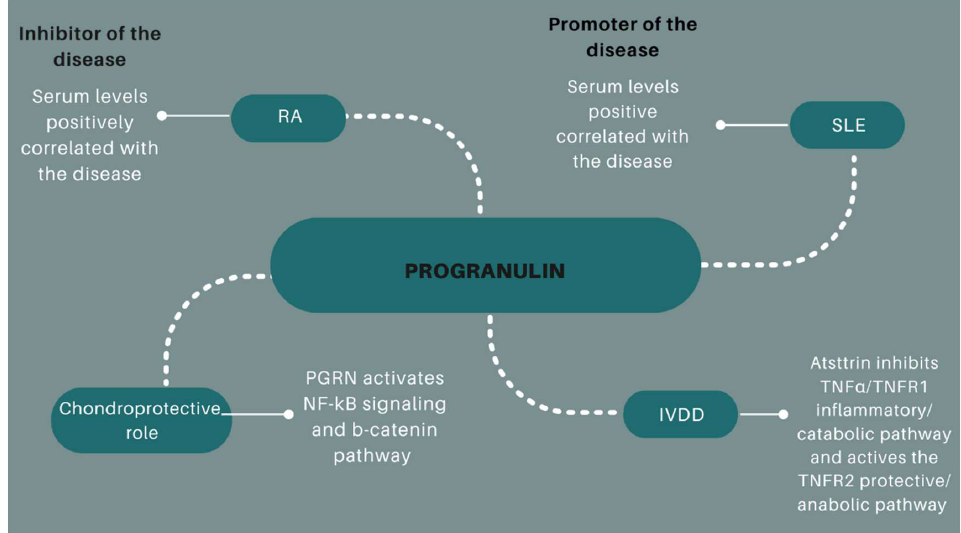
Figure 4. Schematic representation of PGRN relevance in RA, SLE and IVDD.